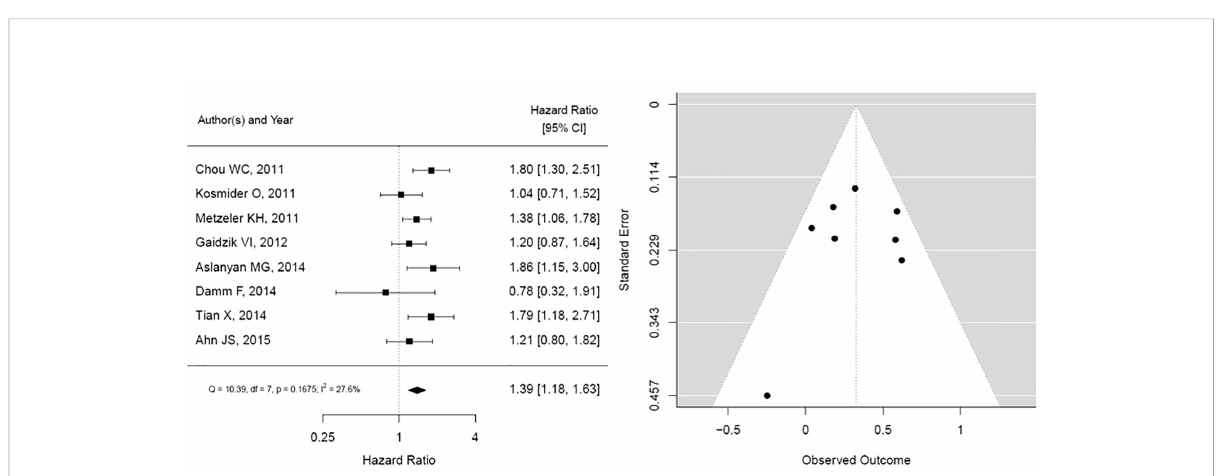
FIGURE 3 Forest plot and funnel plot of the HR for overall survival in TET2 mutation. The fi rst author and year of publication is provided for each study. The hazards ratio (boxes) with 95% con fi dence intervals (CI, horizontal lines) were calculated, the pooled hazards ratio (diamond) was estimated using random effect model. The P value for comparing heterogeneity between subgroups was calculated using I-squared. TET2, Ten-Eleven Translocation